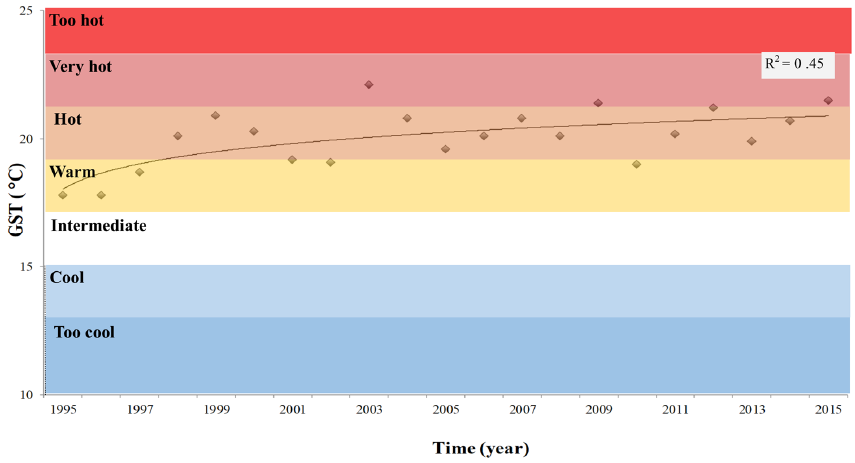
Figure 4 . Growing Season average Temperature (GST) (°C) trend in the white variety growing area (western sub ‐ area). Climate class limits according to Nesbitt et al. [30].